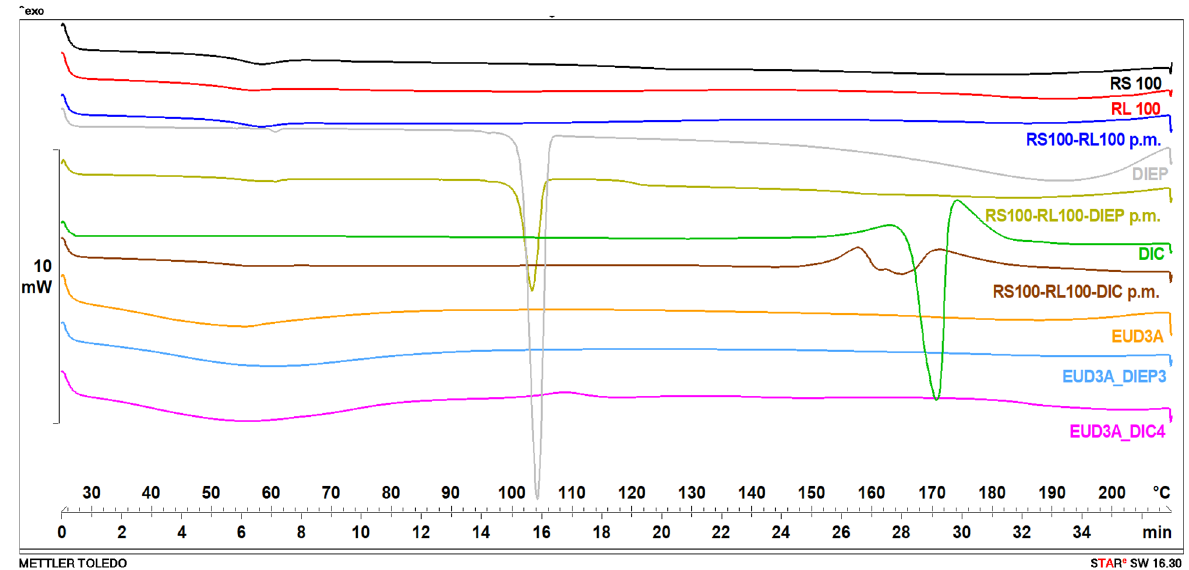
Figure 4. DSC thermograms of RS, RL1, RS/RL physical mixture (p.m.), DIC, DIEP, RS/RL-DIC p.m., RS/RL-DIEP p.m., EUD3A, EUD3A_DIEP3, and EUD3A_DIC4.